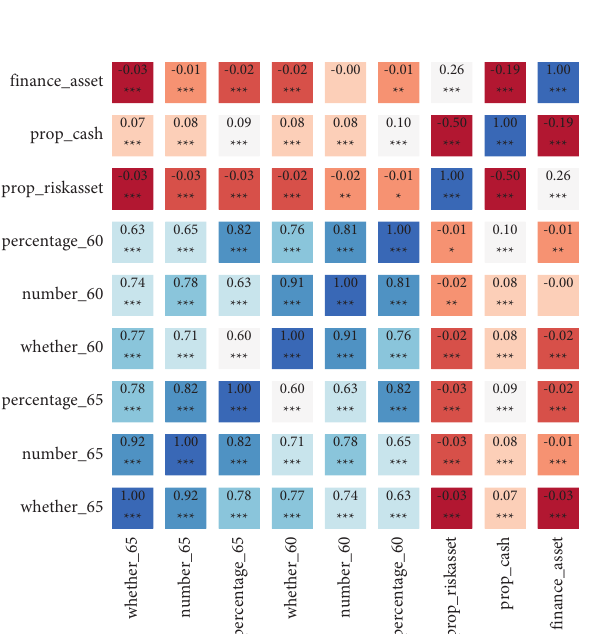
Figure 1: Correlation matrix of key dependent and explanatory variables. Note: ∗∗∗ , ∗∗ , and ∗ denote the significance of the correlation at the 1%, 5%, and 10%